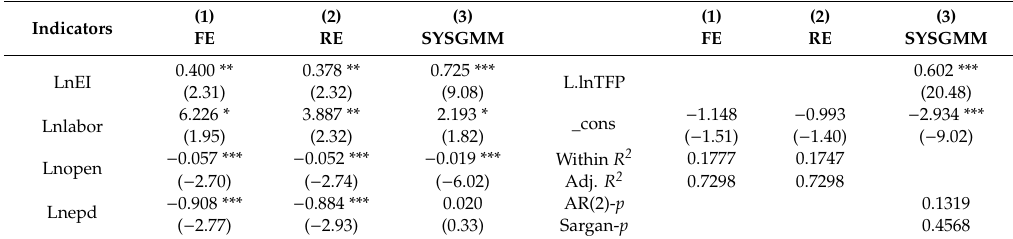
Table 8. Comprehensive Summary of Regression